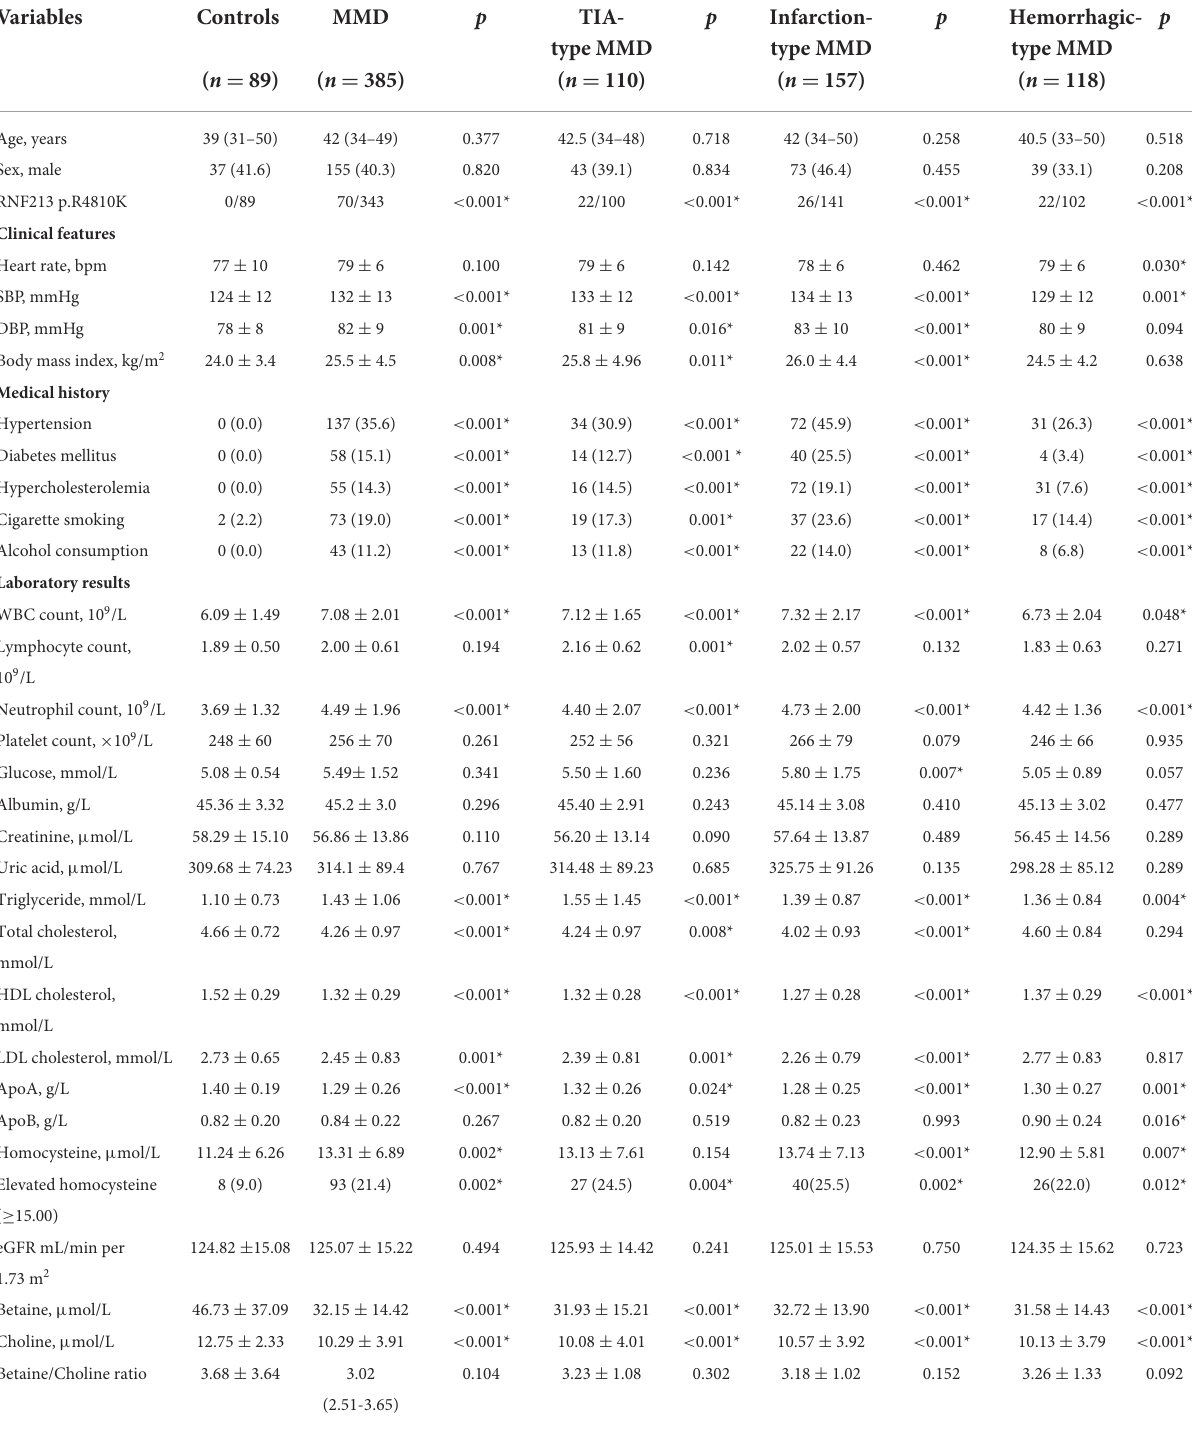
TABLE 1 Clinical and laboratory characteristics in patients with moyamoya disease (MMD) and healthy